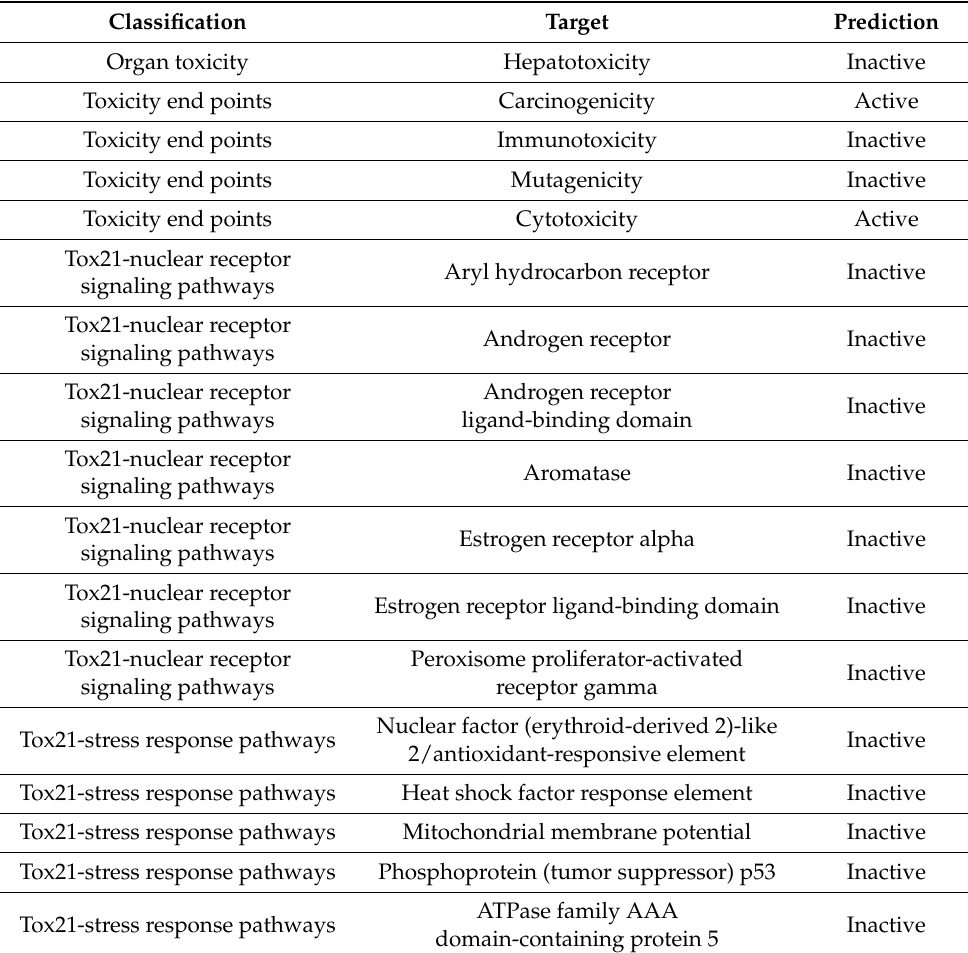
Table 3. Toxicity assessment of ochratoxin A calculated using ProTox-II web-based